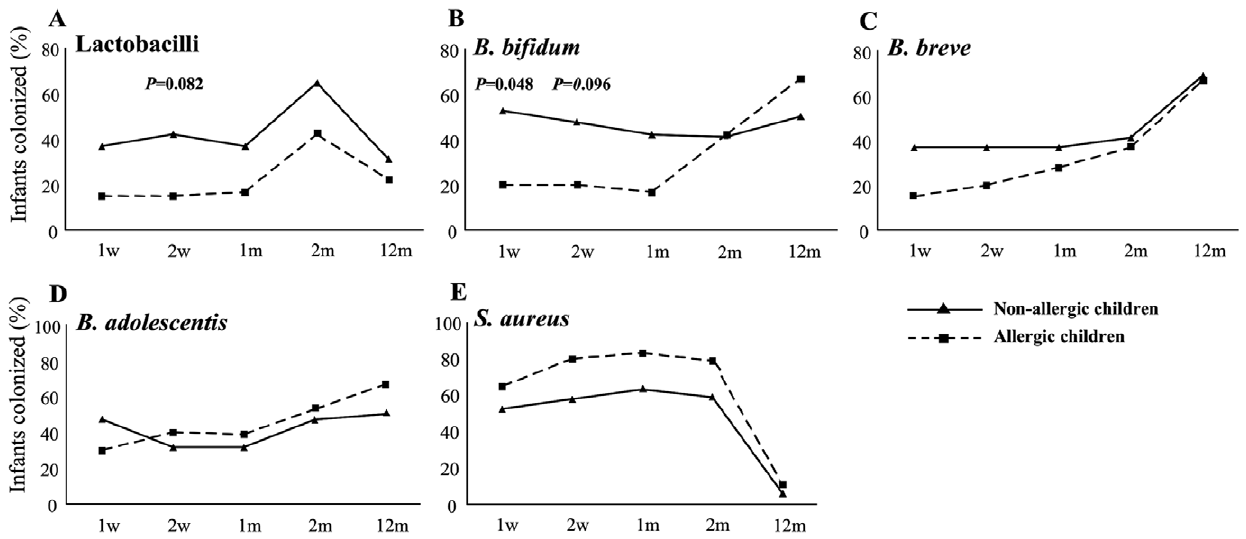
Figure 2. Early life gut microbiota composition associates with allergic disease at age five. The y-axis shows the percentage, colonized with ( A ) Lactobacilli, ( B ) B. bifidum , ( C ) B. breve , ( D ) B. adolescentis and ( E ) S. aureus . Solid line; non-allergic children n=16–19. Dashed line; allergic children n=18–20 (1 v–2 m), n=9 (12 m).